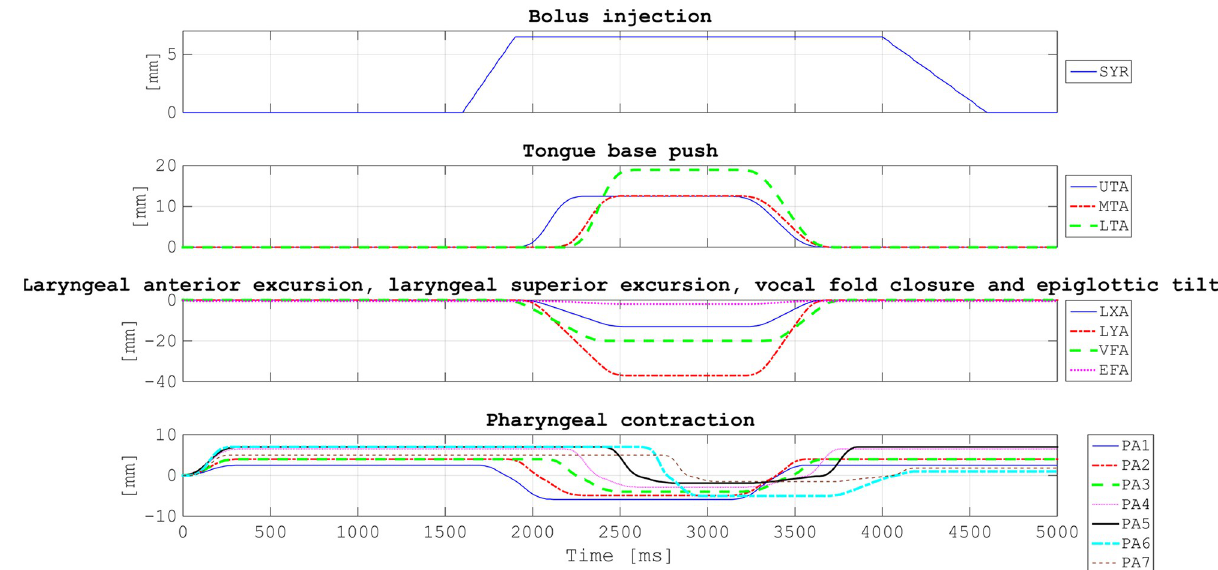
Fig 8. Actuation chronograms mimicking a normal pharyngeal swallow generated in MATLAB. SYR = syringe; UTA = upper tongue actuator; MTA = middle tongue actuator; LTA = lower tongue actuator; LXA = laryngeal anterior actuator; LYA = laryngeal superior actuator; VFA = vocal fold actuator; EFA = epiglottic fold actuator; PA i ( i 2 [1; 7]) = pharyngeal actuator i (from top to bottom). Notes: While the epiglottic actuator delivers only a rotational output instead of a linear output, its actuation chronogram is represented here by a linear displacement in mm like for other actuators (by conversion of number of rotational increments into corresponding linear distance using the screw thread value of the screw-nut systems of the other actuators). The UES opening is coupled to the LYA actuation.